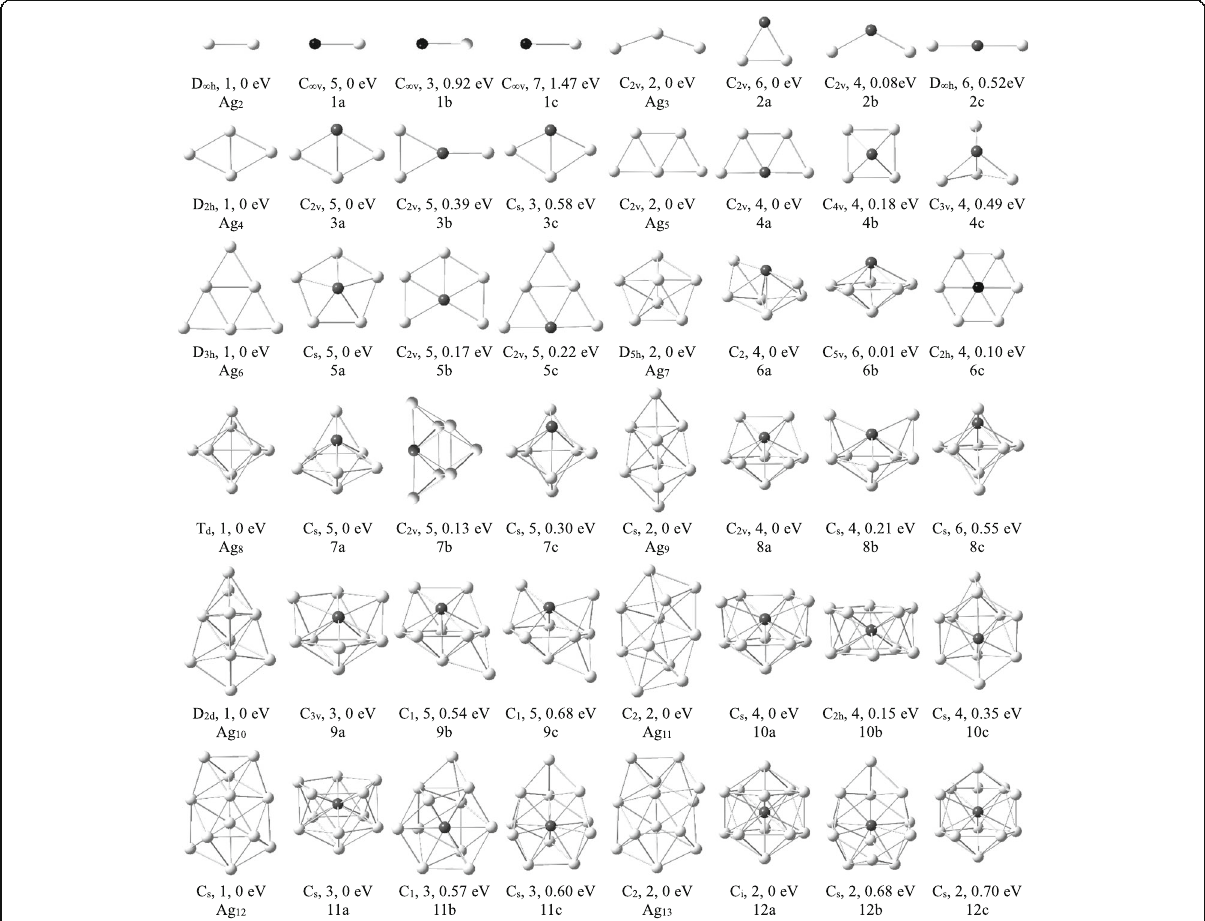
Fig. 1 The ground state structures of Ag n +1 and Ag n V ( n = 2 – 12) clusters. Two low-lying isomers for Ag n V clusters. The symmetry, spin multiplicity, and energy difference are given below them. The gray and black balls denote Ag and V atoms, respectively